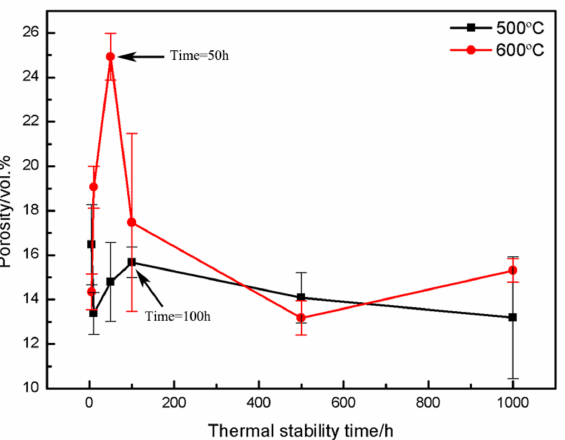
Figure 14. Effect of thermal stabilization time on porosity of the CuAl seal coatings at different oxidation